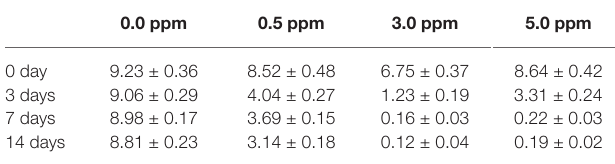
TABLE 1 | The R ct values of the samples in inoculated media with different DOCs (kΩ cm 2